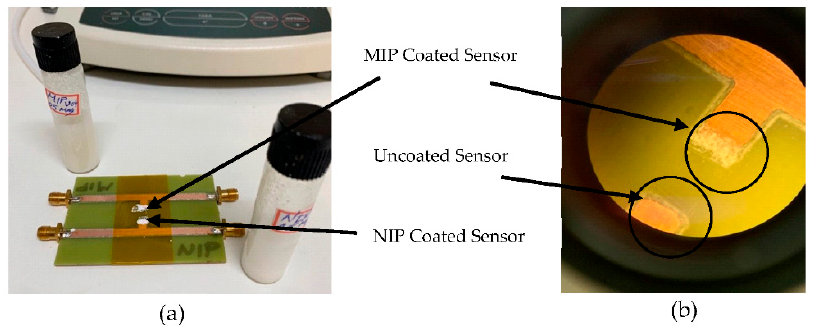
Figure 7. Photograph of ( a ) main fabricated biosensor with the stub resonators coated with MIP and NIP and ( b ) duplicate biosensor coated with MIP and uncoated under the microscope.